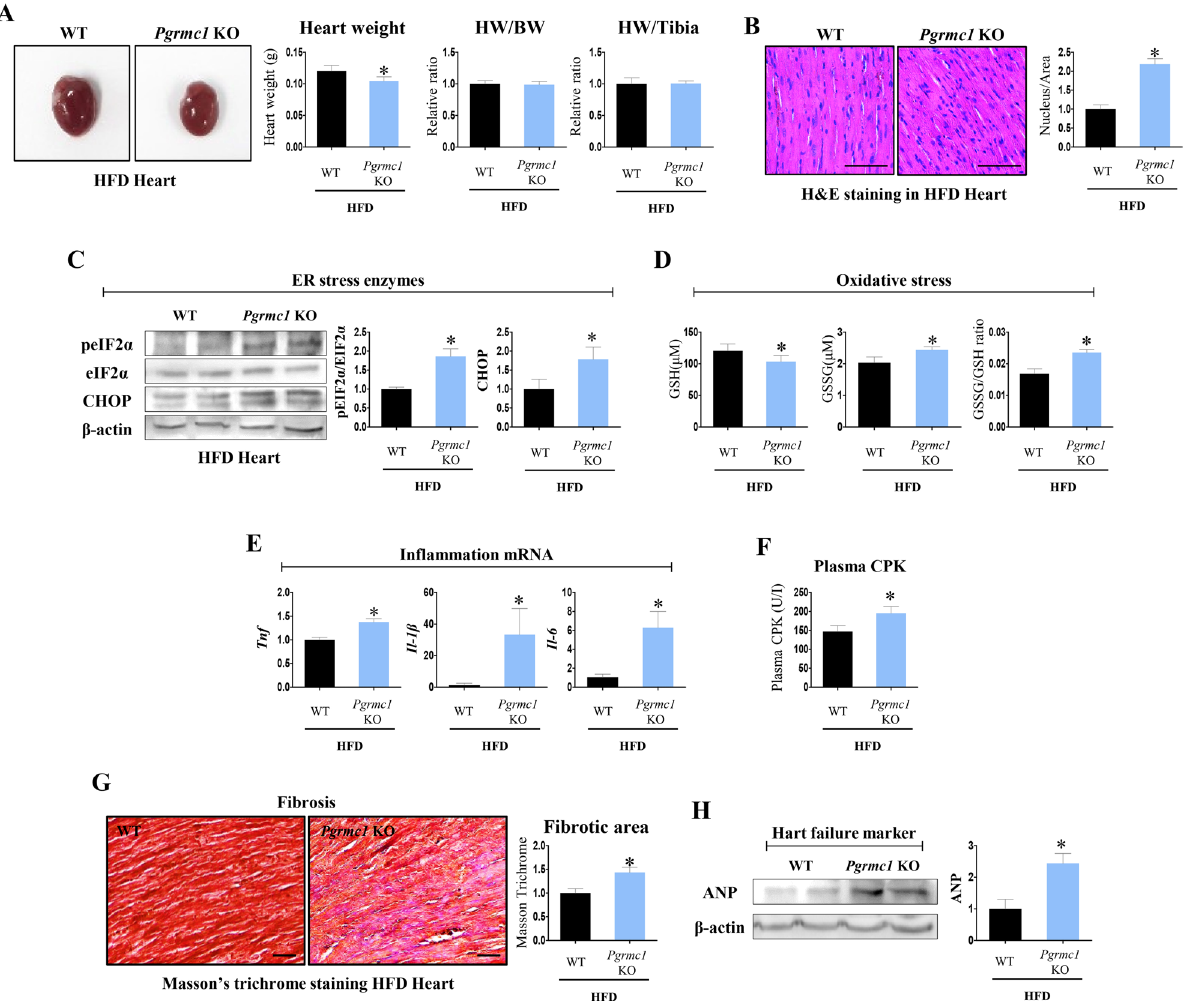
H&E staining of hearts of HFD WT and Pgrmc1 KO mice (scale bar 50 µm). Nucleus per area was measured by Image J program. ( C ) Western blot analysis and quantification of ER stress genes in hearts of HFD WT